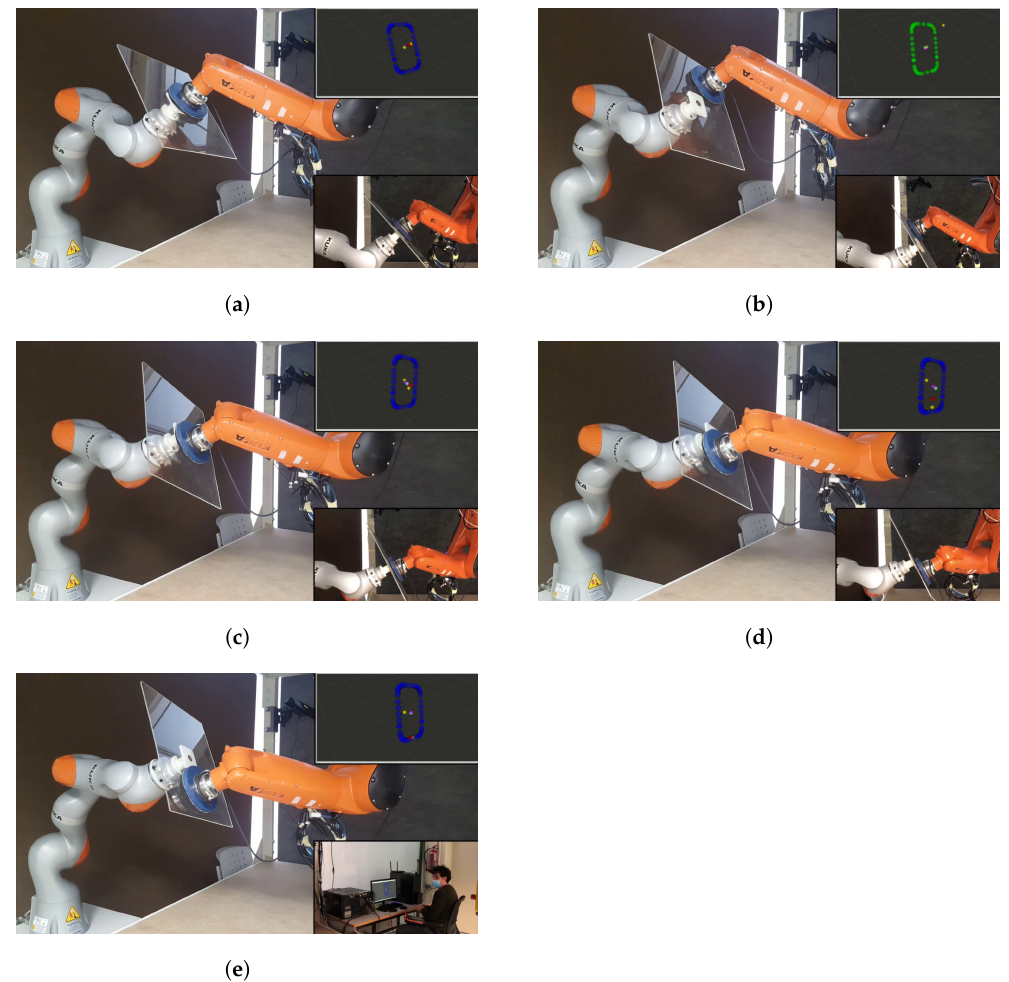
Figure 3. Frames of the video showing the functionalities of the conventional user interface. See the video at https://media.upv.es/player/?id=15ffabe0-a733-11eb-a0b0-2fbcb59aaef7 (accessed on 26 April 2022) [75]. ( a ) Video: 0 m 20 s. ( b ) Video: 1 m 00 s. ( c ) Video: 1 m 24 s. ( d ) Video: 1 m 33 s. ( e ) Video: 1 m 43